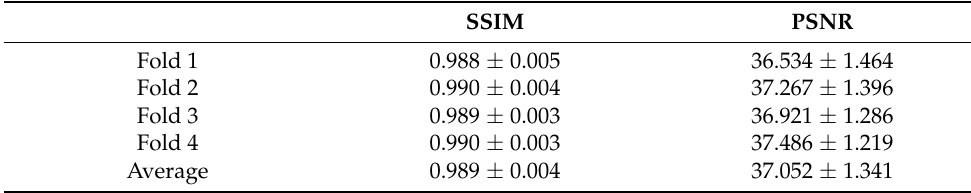
Table 12. Results of four ‐ fold cross ‐ validation.